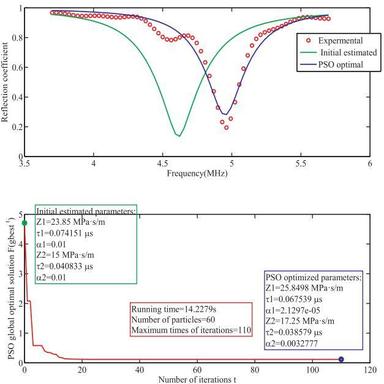
(a) The reflection spectrum of the real measured parameters, initial estimated parameters, PSO optimized parameters and (b) the track of the global optimal solution in the experiment.